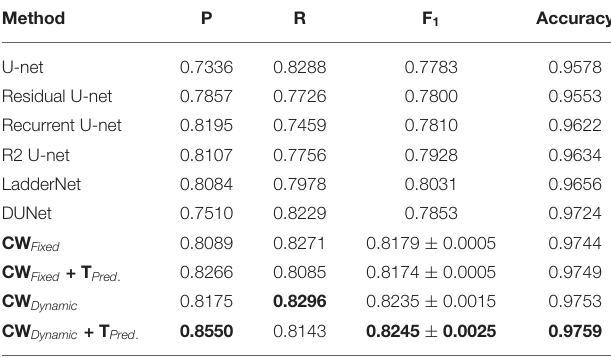
TABLE 3 | Results on CHASE-DB dataset.